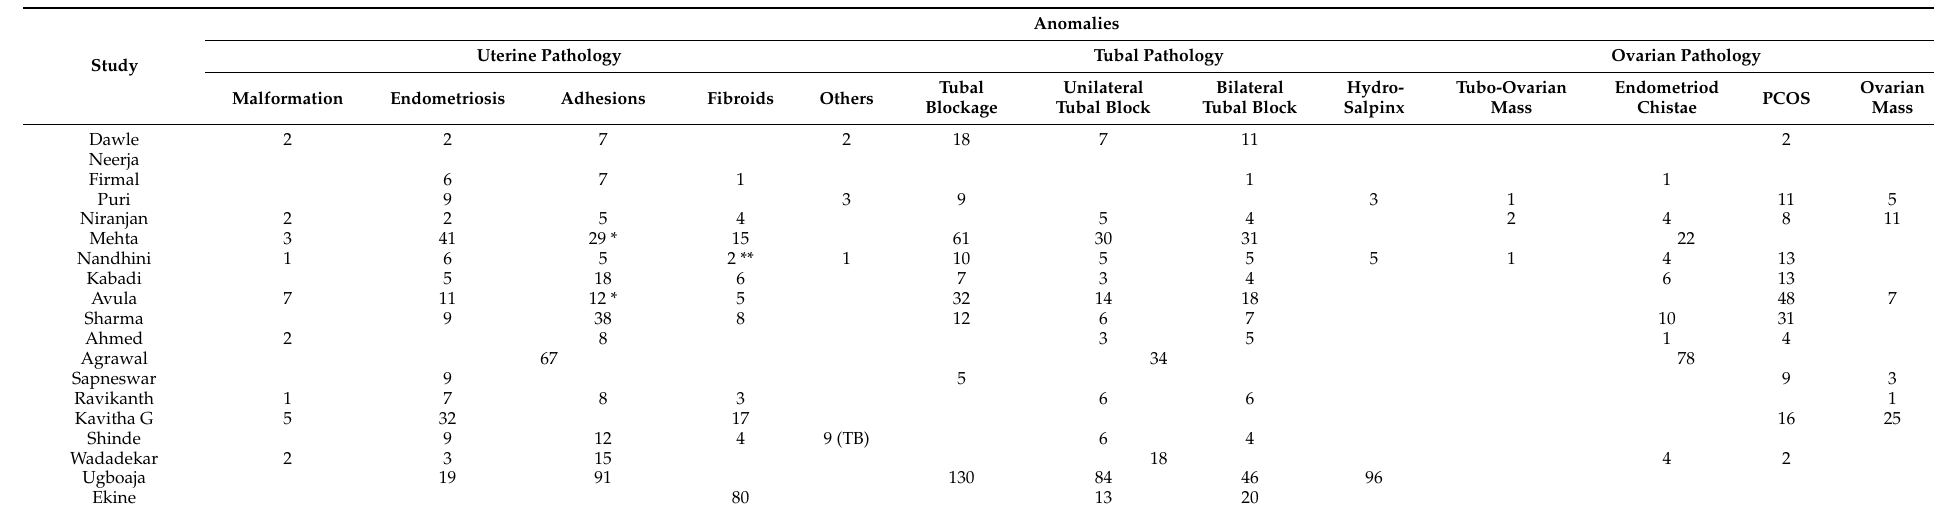
Table 2. Laparoscopic